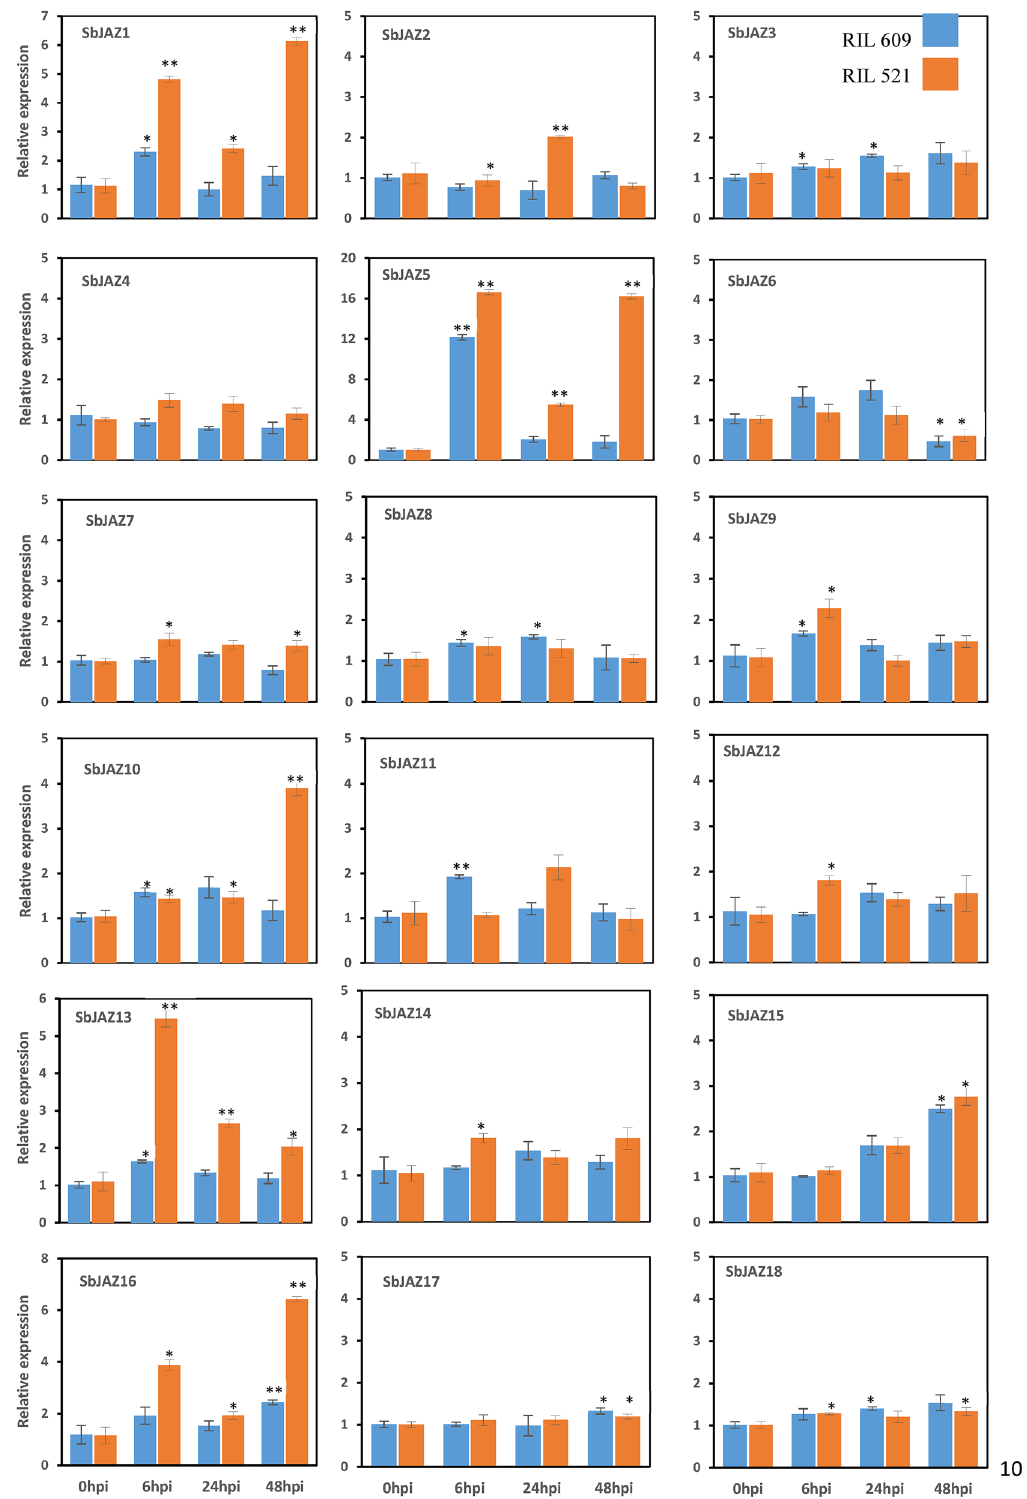
Figure 9. Expression pattern of 18 SbJAZ genes in response to sugarcane aphid infestation in in resistant (RIL 521) and susceptible (RIL 609) RILs to SCA. qRT-PCR was used to determine the relative expression of each SbJAZ gene, and the relative expression was estimated using the 2 −ΔΔCt method. Error bars in each bar represent the ± standard error (n = 3) and asterisks indicate significant differences between the control and phytohormone treated samples, *P < 0.05, **P < 0.01. The bars without asterisk, are non-significant (P >